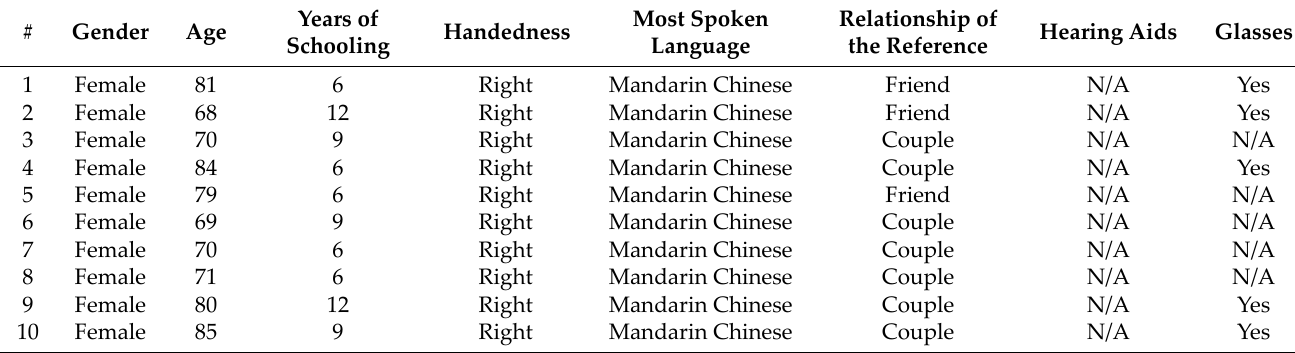
Table 2. Demographic Characteristics of 10 Recommended